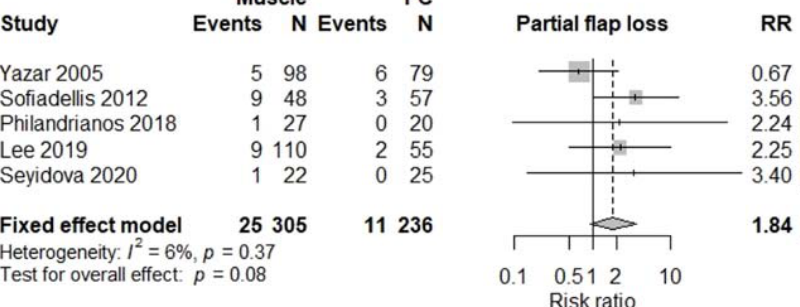
Figure 5. Partial flap loss.